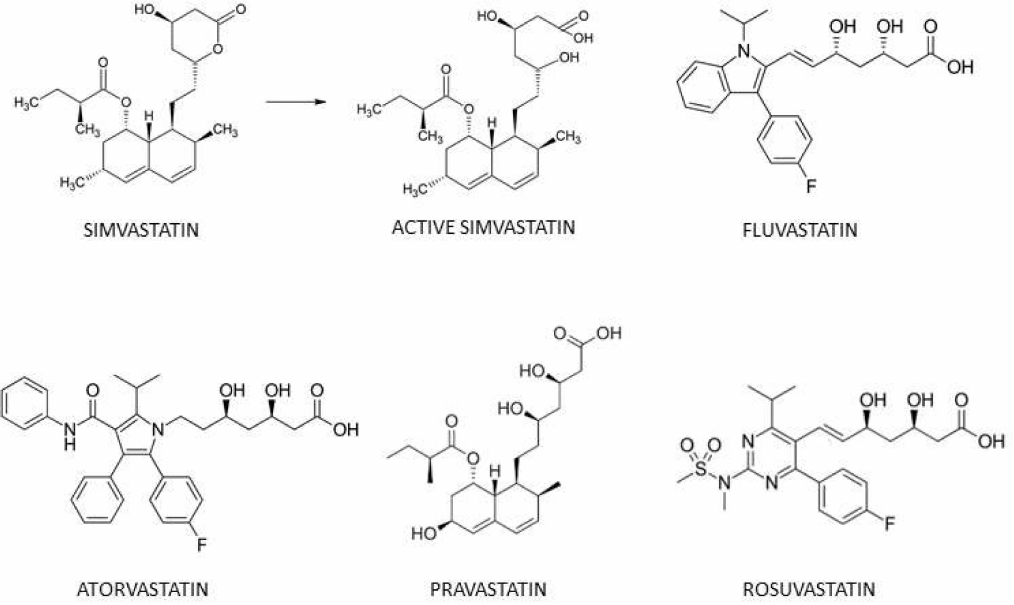
Figure 1. Structure of statins used in the present study: simvastatin, the active metabolite of simvas- tatin, fluvastatin, atorvastatin, rosuvastatin and